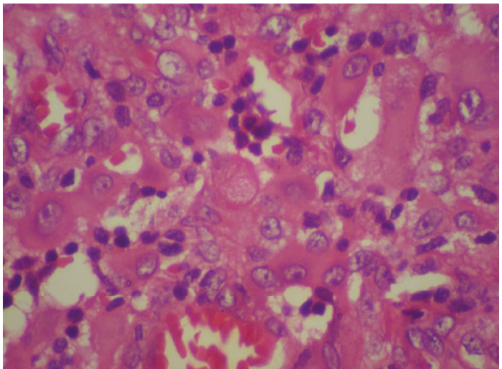
Figure 5: Dilated venules and capillaries with erythrocytes inside. Histiocytes with an eosinophilic glassy cytoplasm and vesiculosus nuclei. Also, lymphocytes and eosinophils were seen